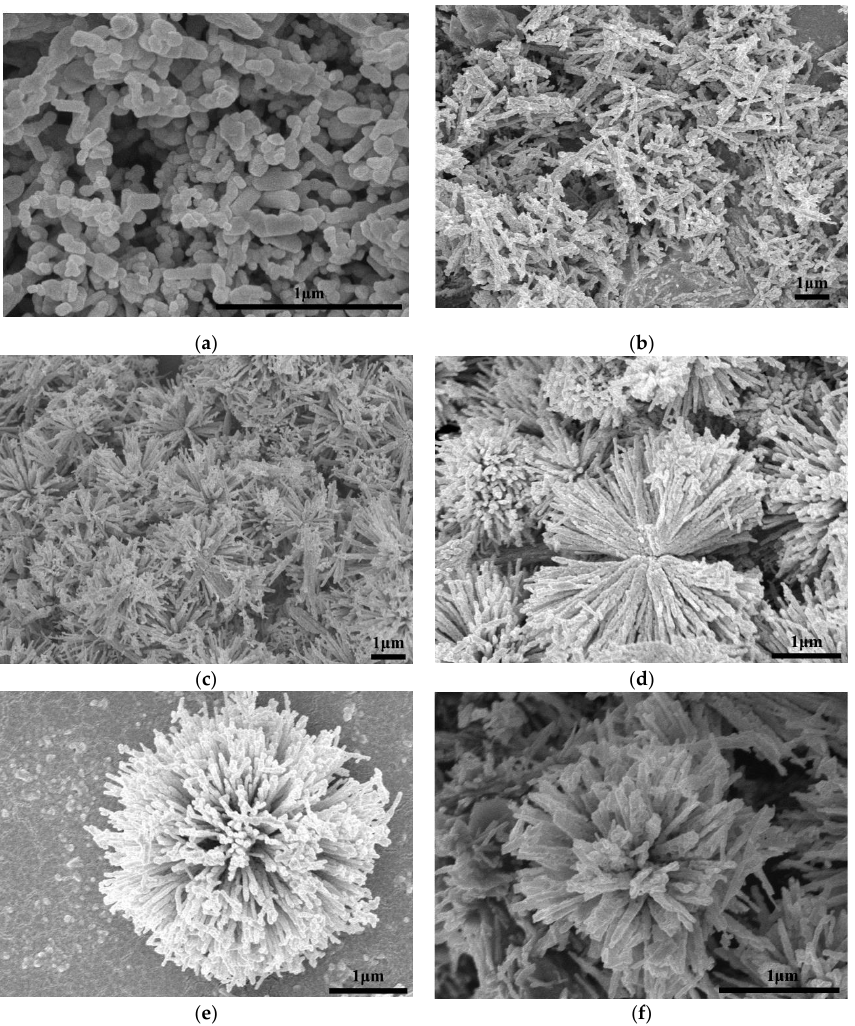
Figure 2. Morphology of CuO microspheres obtained at room temperature with varied time of dropping of NaOH: 5 min ( a ), 15 min ( b ), 25 min ( c ), 35 min ( d ), 45 min ( e ), and 55 min ( f ).